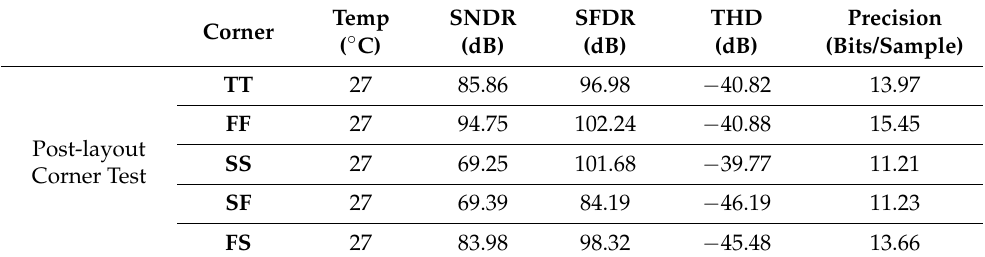
Figure 23. The Monte Carlo analysis of the proposed modulator’s SNDR for various processes and mismatching. Table 9. The post-layout results of the corner and power supply tests.